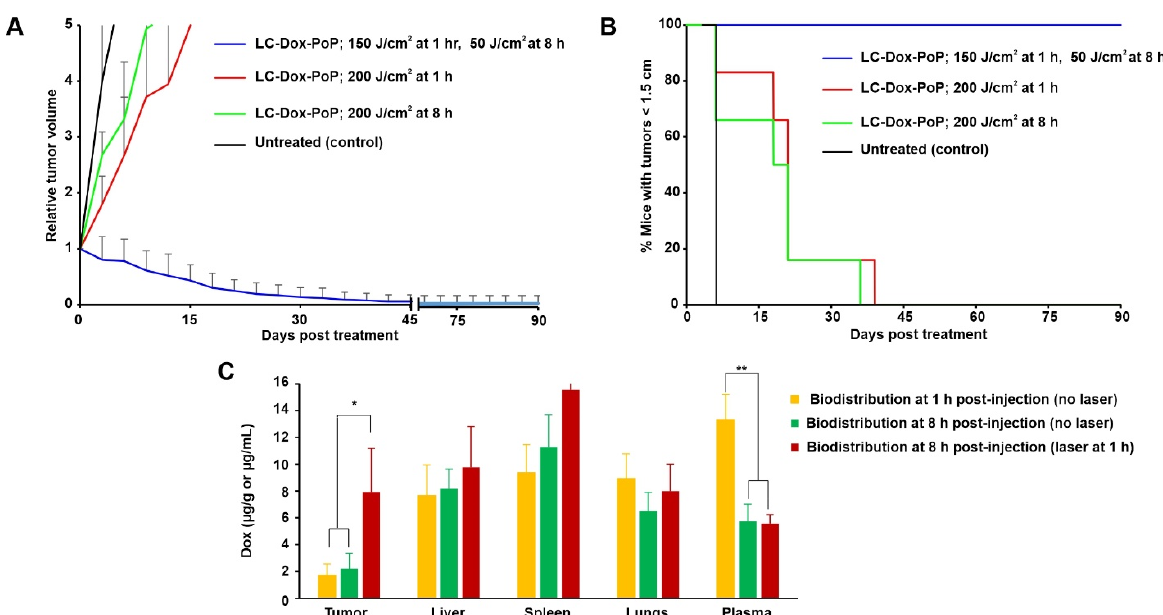
Figure 3. Impact of a second laser treatment on anti-tumor efficacy and biodistribution. Mice bearing MIA PaCa-2 tumors were untreated or intravenously injected with 3 mg/kg LC-Dox-PoP liposomes. One group of mice was treated with a 665 nm laser with laser fluence rate of 150 mW/cm 2 at total fluence of 150 J/cm 2 at a 1 h DLI and a second laser treatment with 50 J/cm 2 at a 8 h DLI. The other two groups received laser treatments with a 665 nm laser at a total fluence of 200 J/cm 2 at either a 1 h DLI or at 8 h DLI respectively. ( A ) Relative tumor growth data. ( B ) Percentage of mice with tumors less than 1.5 cm over time. n = 6 mice per group. ( C ) Tissue and plasma biodistribution of Dox and PoP . Mice bearing MIA PaCa-2 tumors were intravenously injected with 3 mg/kg LC-Dox-PoP liposomes. One group was treated with a 665 nm laser with a fluence rate of 150 mW/cm 2 and a total fluence of 150 J/cm 2 with a 1 h DLI. Mice were sacrificed at 1 or 8 h, and tumor and other organs were collected for biodistribution analysis. Data show mean ± std. dev. for n = 4 mice per group. * p < 0.05, ** p < 0.01, analyzed by one-way ANOVA with Tukey’s Multiple comparison test in C.